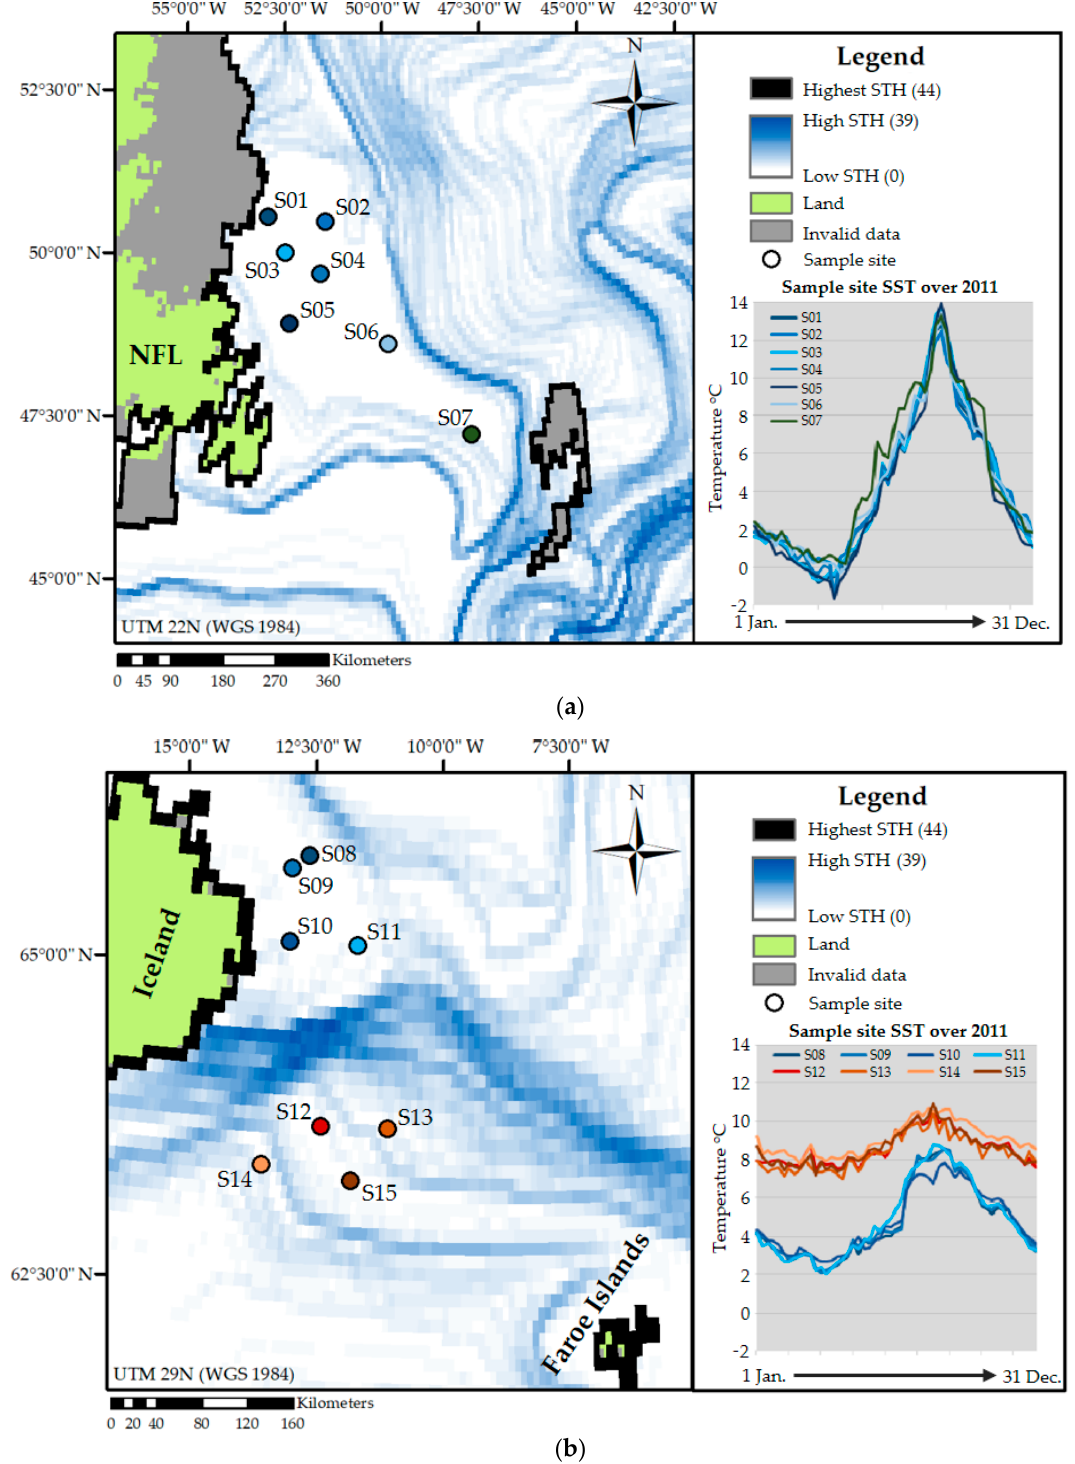
Figure 7. Examples of how high STH areas bound spatio-temporally homogeneous regions, and also separate regions with different temporal signals. ( a ) A sample of temporal signals taken from within a homogeneous region in terms of STH, located off the eastern coast of Canada; ( b ) A sample of temporal signals taken from a region bisected by a locally strong STH feature located off the East coast of Iceland. Both panels show how the underlying raster STH dataset captures the delineations between clusters, and not the clusters themselves. ters that represent the variability in the hypertemporal datacube, and (ii) a signature file